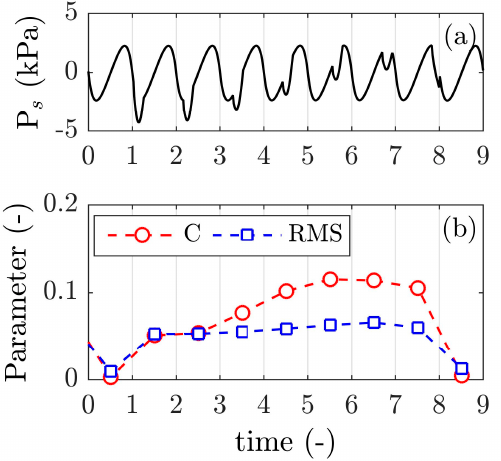
Figure 9. Effect of the position of a perturbation in the blade passage signature on the Correlation and RMS parameters. ( a ) Perturbed signal; ( b ) Correlation and RMS response.